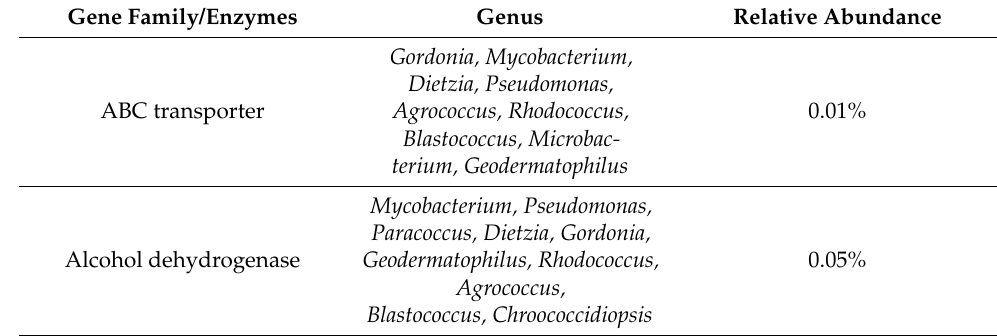
Table 4. Main gene families, enzymes, and pathways directly or indirectly involved in hydrocarbon degradation, as well as associated genera identified in metagenomic data of SGP. Genes’ relative abundance represents the proportion of the specific gene compared to the total number of functional genes. Pathways’ relative abundance represents the proportion of the specific pathway compared to the total number of